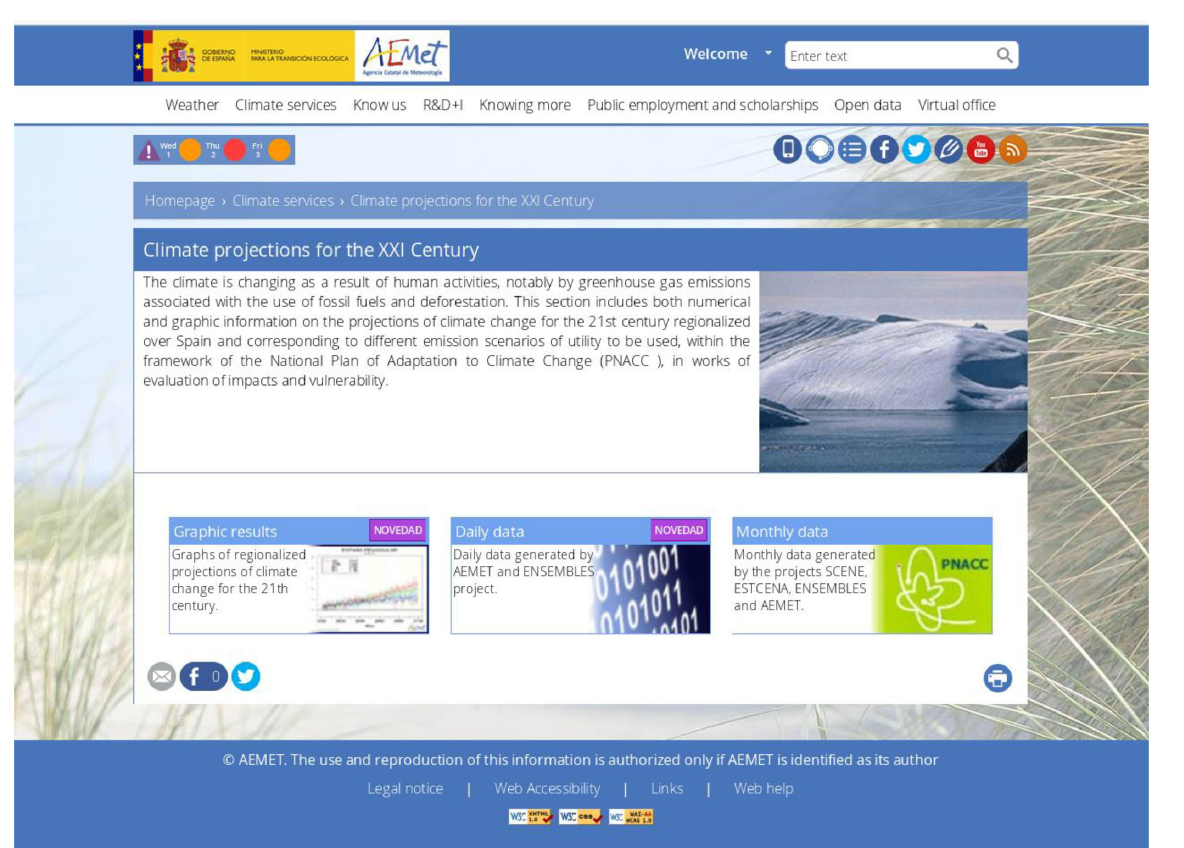
Figure 5. AEMET Web portal (https://www.aemet.es/en/serviciosclimaticos/cambio_climat, last access: 1 August 2018). Date of screenshot: 1 August